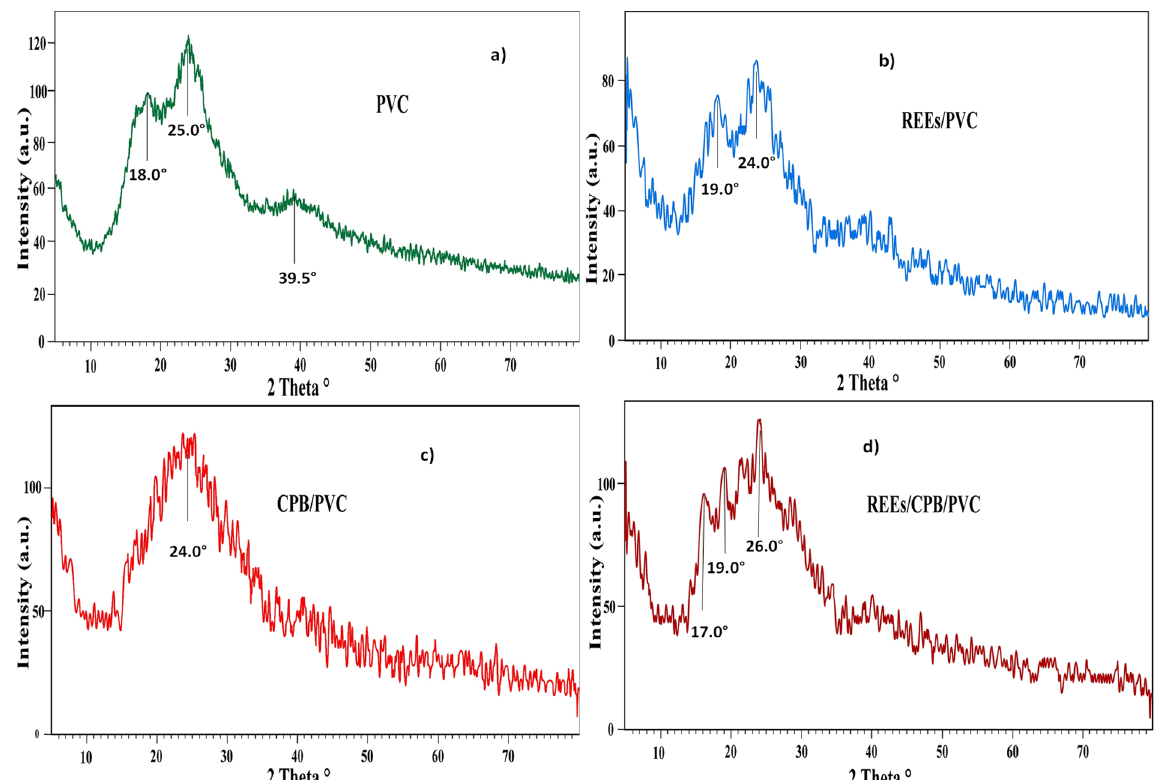
Figure 1. XRD analysis of ( a ) PVC, ( b ) REEs/PVC, ( c ) CPB/PVC, ( d ) REE/CPB/PVC.